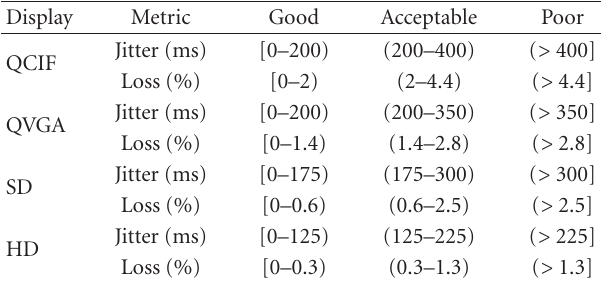
Table 4: Jitter and loss GAP ranges under PFIFO.